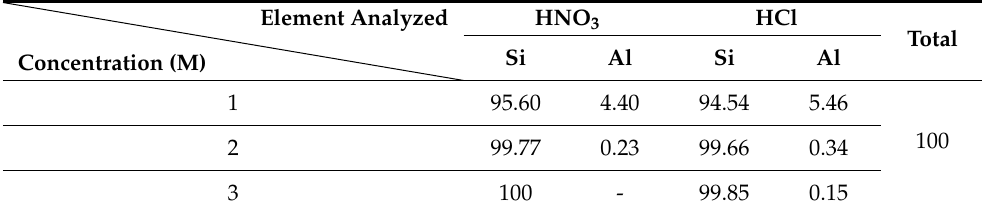
Table 1. XRF analysis results of a photovoltaic cell after drying — concentration (unit: wt.%). Element Analyzed